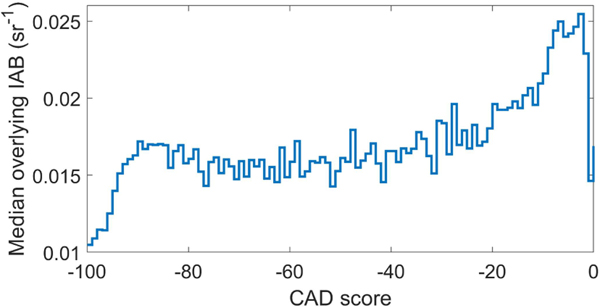
Median overlying integrated attenuated backscatter (IAB) for aerosol layers having the indicated CAD score for 2010, at night, global.